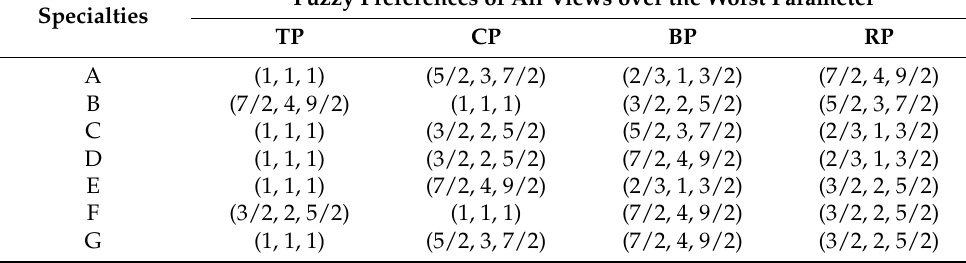
Table 8. The FOW